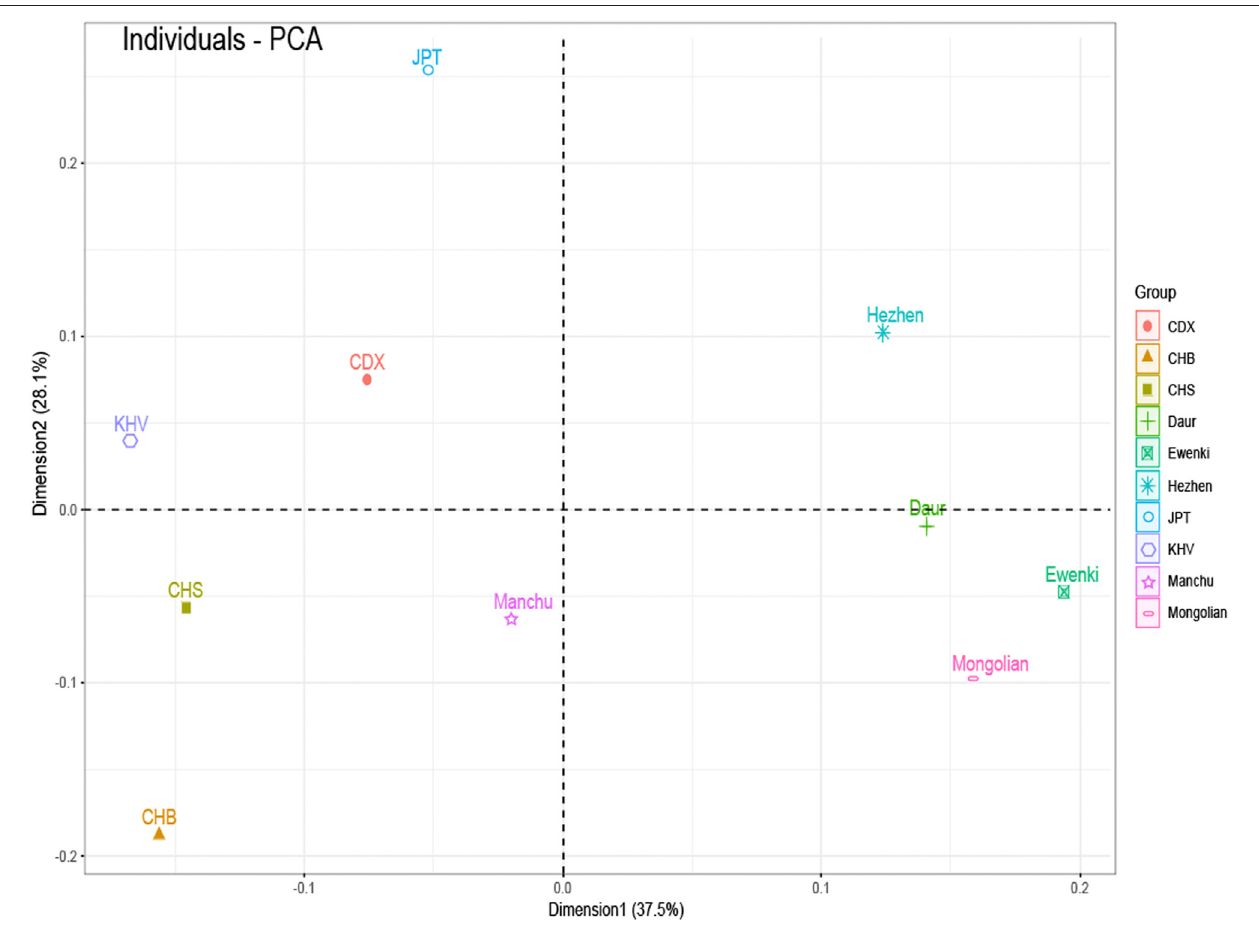
FIGURE 3 | PCA based on the minimum allele frequency of the Asia populations. Note: CDX: Chinese Dai in Xishuangbanna; CHB: Han Chinese in Beijing; CHS: Southern Han Chinese; JPT: Japanese in Tokyo; KHV: Kinh in Ho Chi Minh City, Vietnam.